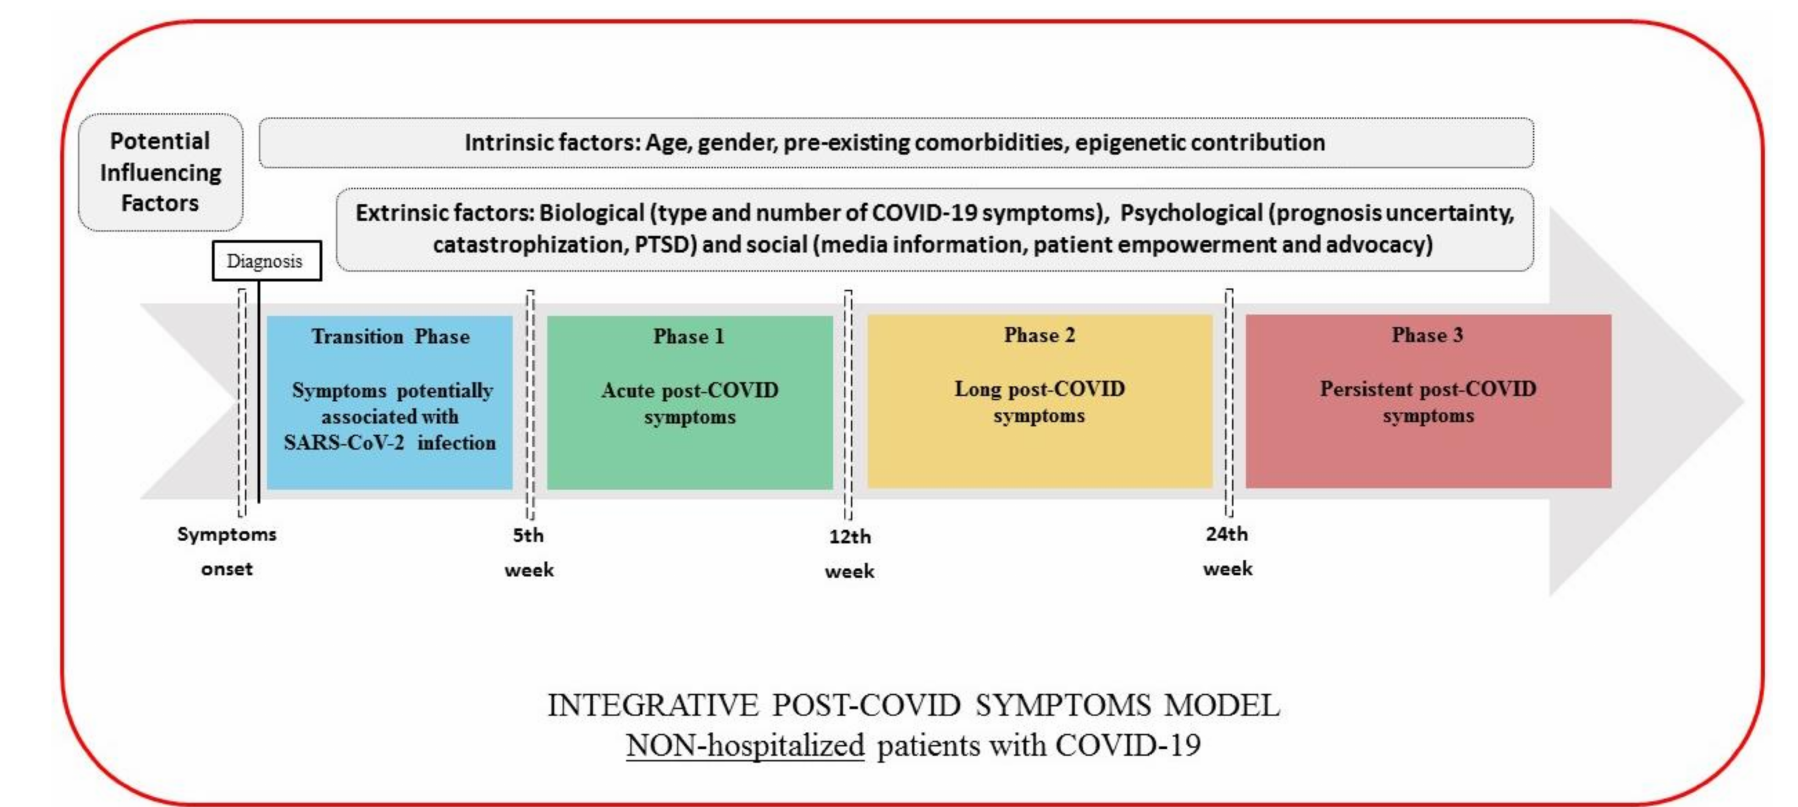
Figure 1. Integrative post-COVID symptoms model in non-hospitalized patients showing transition phase (blue), and phases 1 (green), 2 (yellow), and 3 (red) of post-COVID symptoms. PTSD: post-traumatic stress